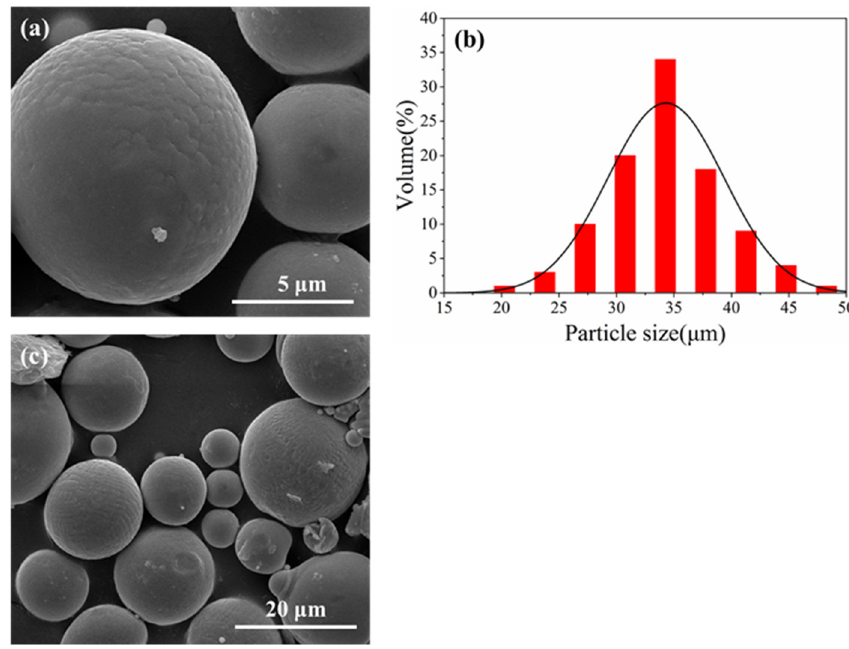
Figure 1. ( a ) SEM image of FeCoNiAlTi HEA powders, ( b ) the particle size distribution of FeCoNi-